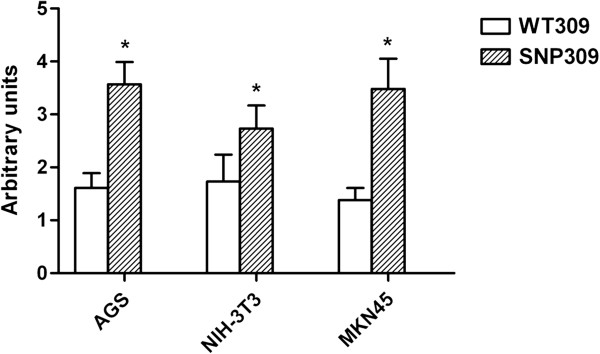
Effect of MDM2 SNP309 in the transcriptional activity of MDM2 promoter. Data are expressed as mean and standard deviation of three independent experiments. WT309, cells transfected with allele 309 T; SNP309, cells transfected with allele 309 G; * P < 0.01, compared with WT309.